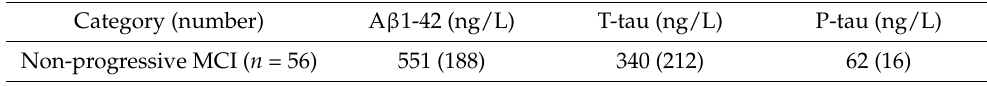
Table 2. Summary of published findings from ( a ) Hansson et al. [32] and ( b ) Buchhave et al. [44] to determine the analyte values in patients who progress to dementia after early and late follow up, respectively, ( c ) our calculated mean values of the three CSF analytes for the 15 patients who were initially classified as non-progressive (stable MCI) but who in fact were reported as having progressed at late follow up.